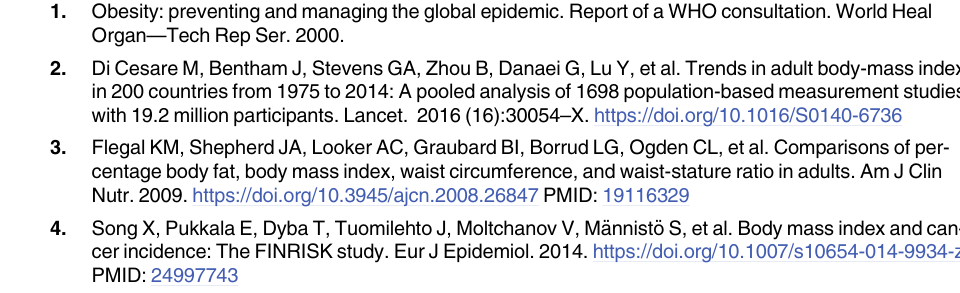
S3 Table. SNPs used as instrumental variables in the multivariable MR analyses of fat mass and fat-free mass indices. MR, mendelian randomisation; SNP, single nucleotide polymor- phism. (PDF) S4 Table. SNPs used in the analyses of height. SNP, single nucleotide polymorphism. (PDF) S5 Table. Supplementary analyses of the association between genetically predicted BMI (per 1 kg/m 2 increase) and cancer. BMI, body mass index. (PDF) S6 Table. Supplementary analyses of the association between genetically predicted height (per 1 standard deviation increase) and cancer